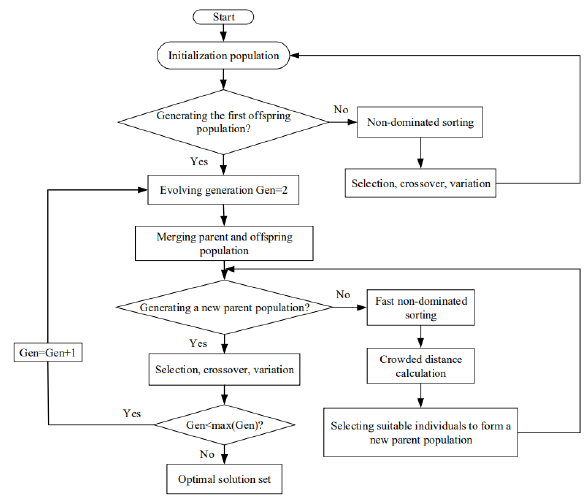
Figure 2. NSGA-II algorithm flow chart. E and E as optimization objectives; takes the boundary This paper takes P , , P energy ( E ) and resonance width ( E ) as optimization variables; and applies NSGA-II algorithm to optimize the ESE heat engine with single-, bi-, tri- and quadru-objective op- timizations. According to Reference [39],